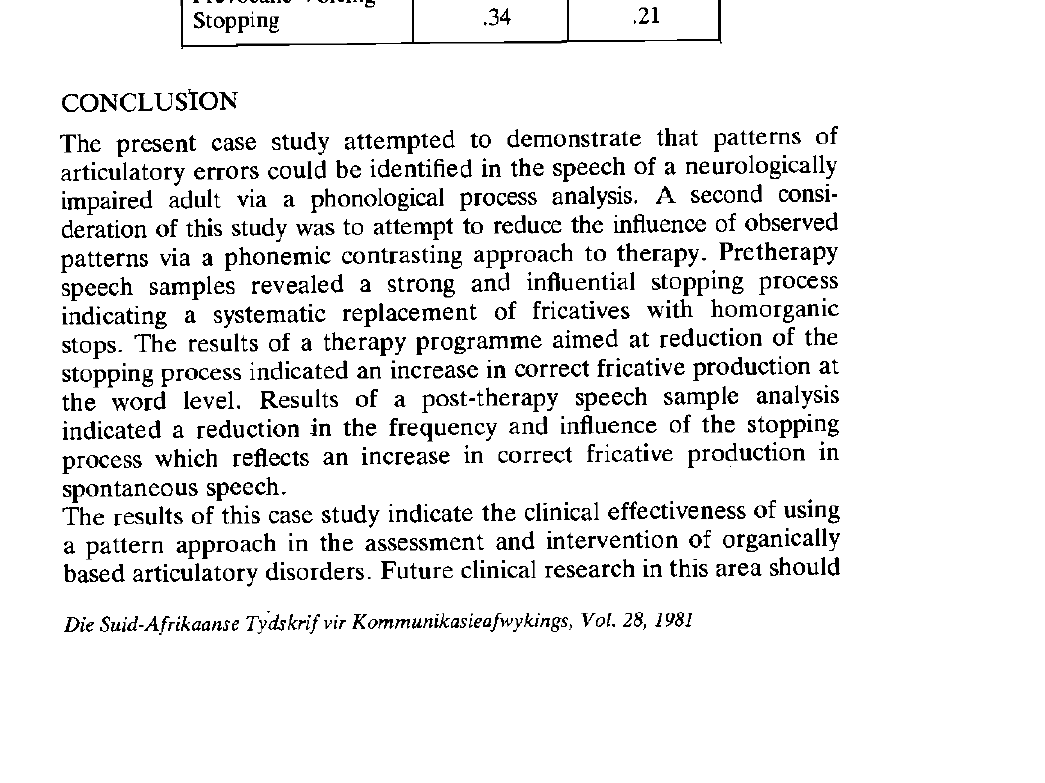
TABLE IV: Spontaneous Speech Analysis: RIU Comparisons Process Pre-Therapy Post-Therapy Deletion Final Con. .20 .13 Cluster Reduction .25 .14 Prevocalic Voicing .12 .14 Stopping .34